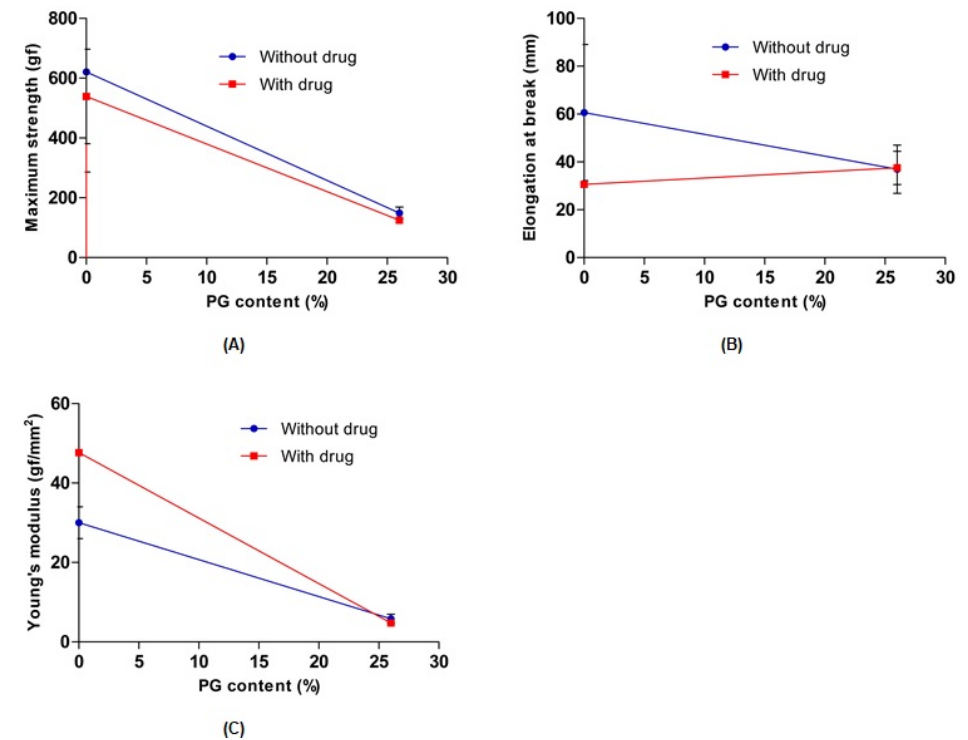
Figure 5. Effect of propylene glycol (PG) on the maximum strength ( A ), elongation at break ( B ), and Young’s modulus ( C ). Data are expressed as the mean ± standard deviation ( n =